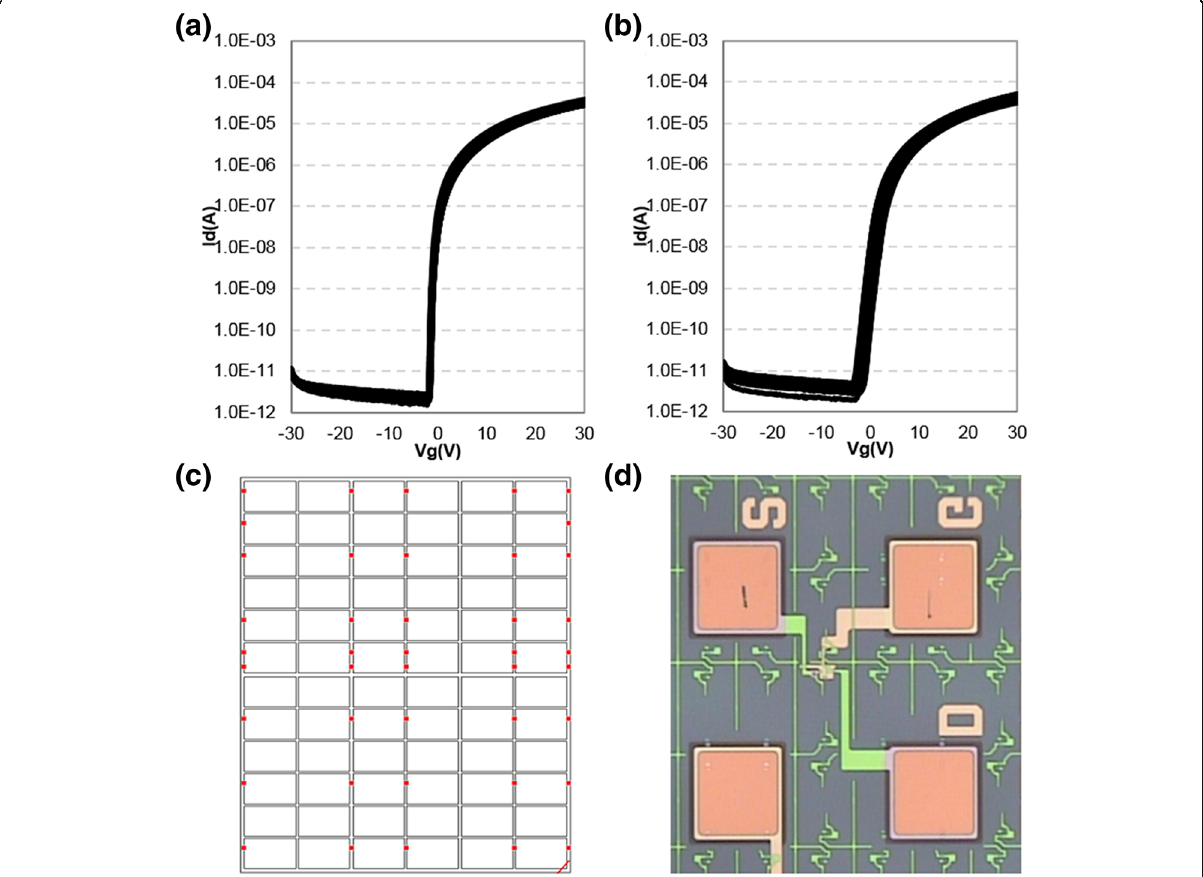
Fig. 5 (Color online) a CL-ES structure. b BCE structure ’ s TFTs I-V transfer characteristic. c 42 measuring points. d the photo of TFT. All measured on an 8.5 generation